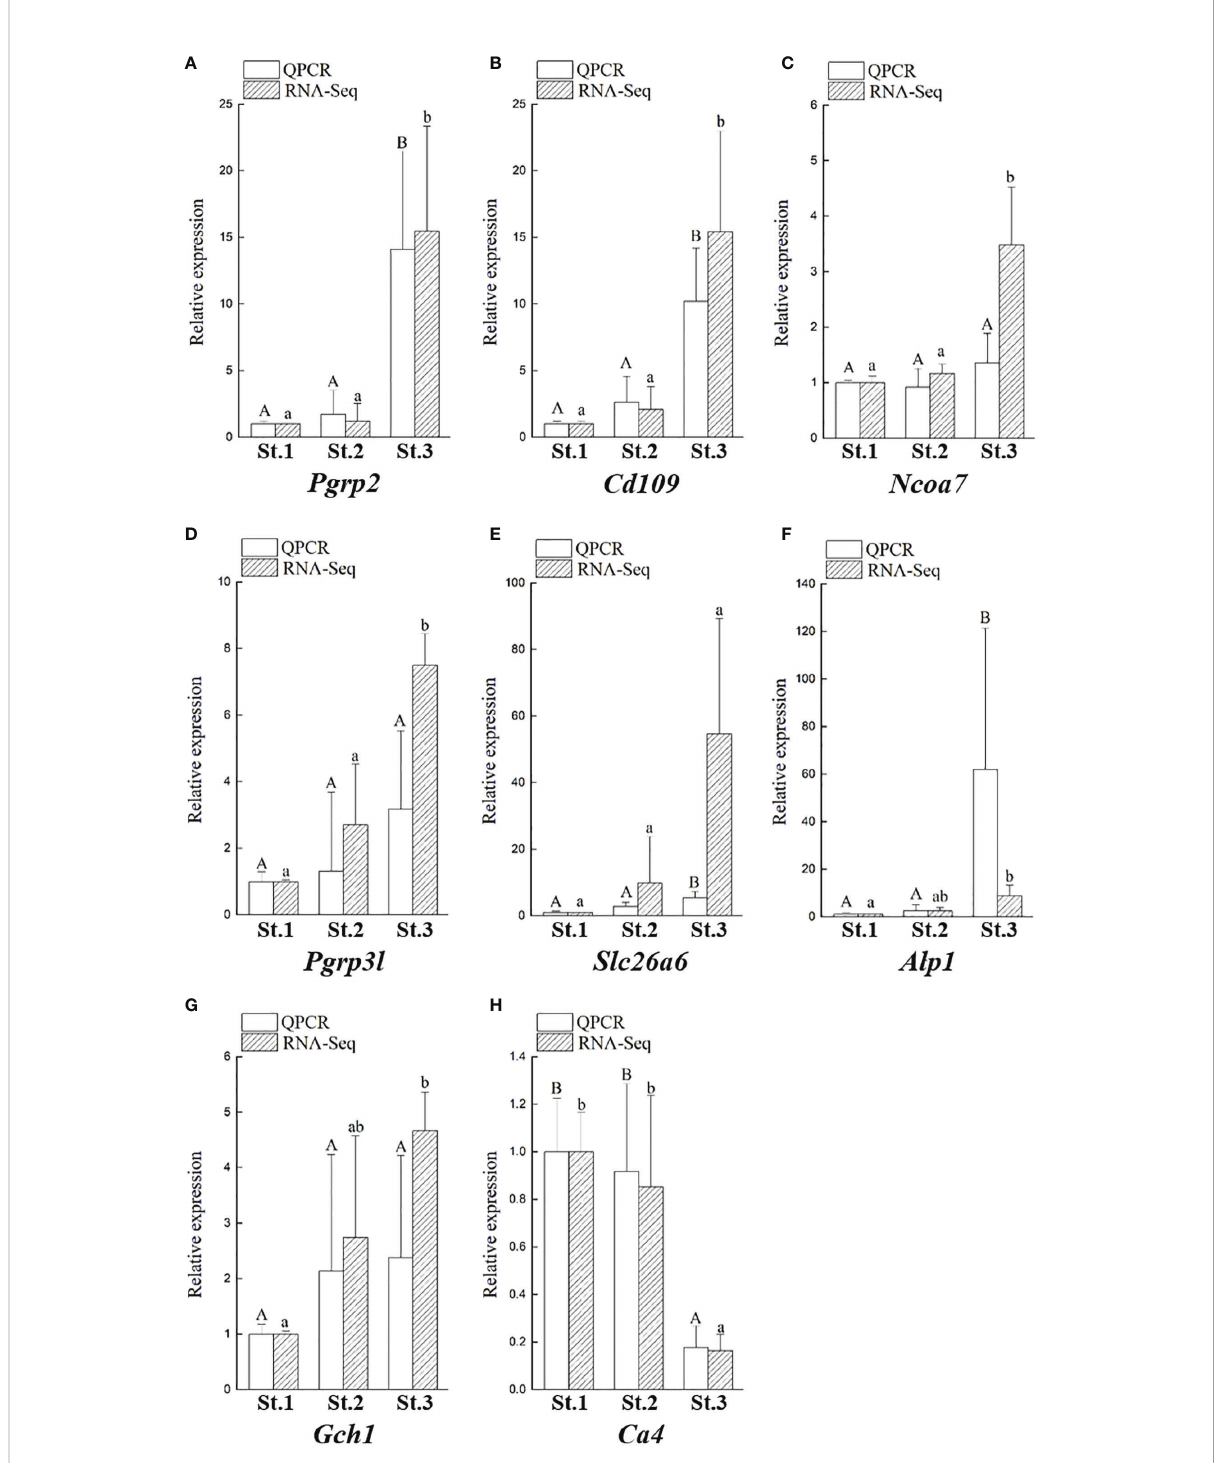
FIGURE 8 Validation of eight DEGs obtained from the transcriptomic results by qPCR. Comparison of transcriptomic levels, and gene transcripts calculated from qPCR during ANG growth in female squids, including Pgrp2 (A) , Cd109 (B) , Ncoa7 (C) , Pgrp3l (D) , Slc26a6 (E) , Alp1 (F) , Gch1 (G) , and Ca4 (H) . Data are expressed as the mean ± SD. Different letters indicate signi fi cant differences between stages of ANGs (P < 0.05). St, stage; Alp1 , alkaline phosphatase 1 ; Cd109 , cluster of Differentiation 109 ; Gch1 , GTP cyclohydrolase 1 ; Ncoa7 , nuclear receptor coactivator 7 ; Pgrp2 , peptidoglycan recognition protein 2 ; Pgrp3l , peptidoglycan recognition protein 3-like, peptidoglycan recognition protein 3-like ; Slc26a6 , solute carrier family 26 member 6